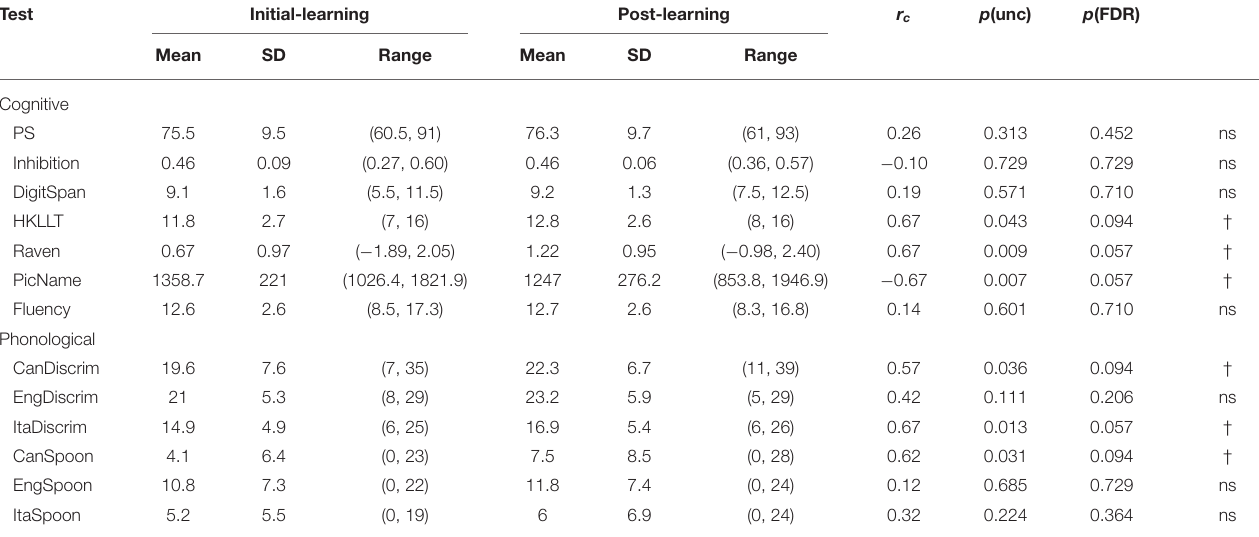
TABLE 7 | Comparisons of cognitive and phonological scores between initial- and post-learning phases.